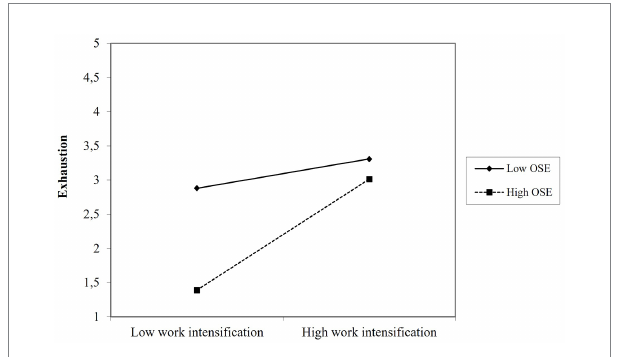
FIGURE 4 Moderation effect of organizational self-efficacy on the work intensification-exhaustion relation.